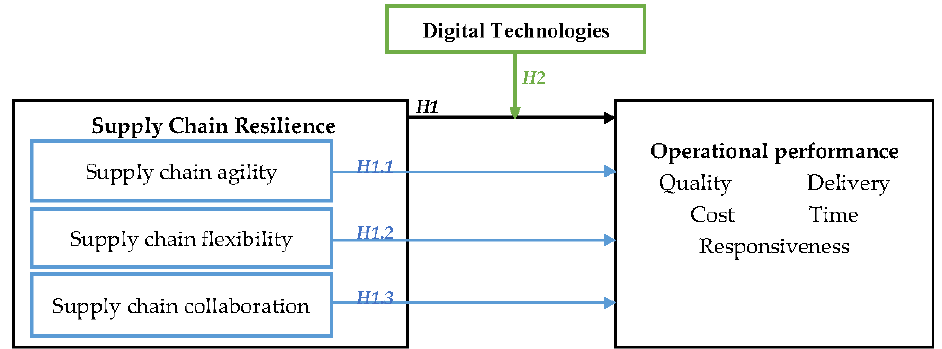
Figure 1. Research Figure 1. Research model.